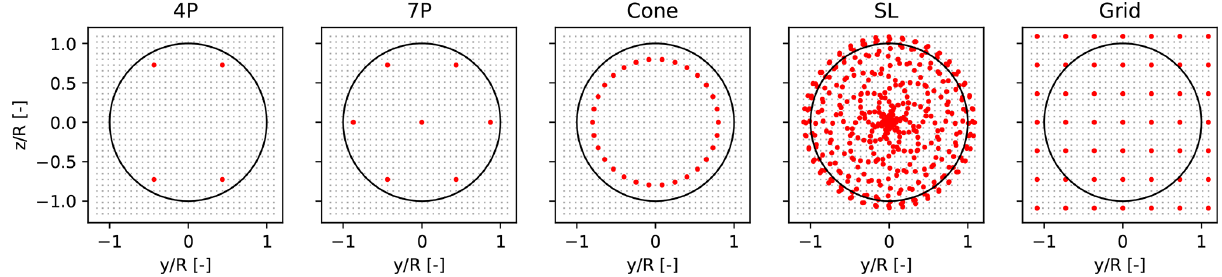
Figure 4. Selected lidar scanning patterns for the load analysis. The red markers indicate the scanned locations, and the black dots in the background define the spatial resolution of the turbulence box. The rotor diameter is shown as a solid black line. Table 1. Technical properties of the simulated lidar scanning configurations. Note that the Cone and SL measurements are binned according to the spatial resolution of the synthetic turbulence fields, thus leading to a reduction in the simulated scanning positions. Scanning Measurements/ Sampling Scan Measurements/ Probe volume